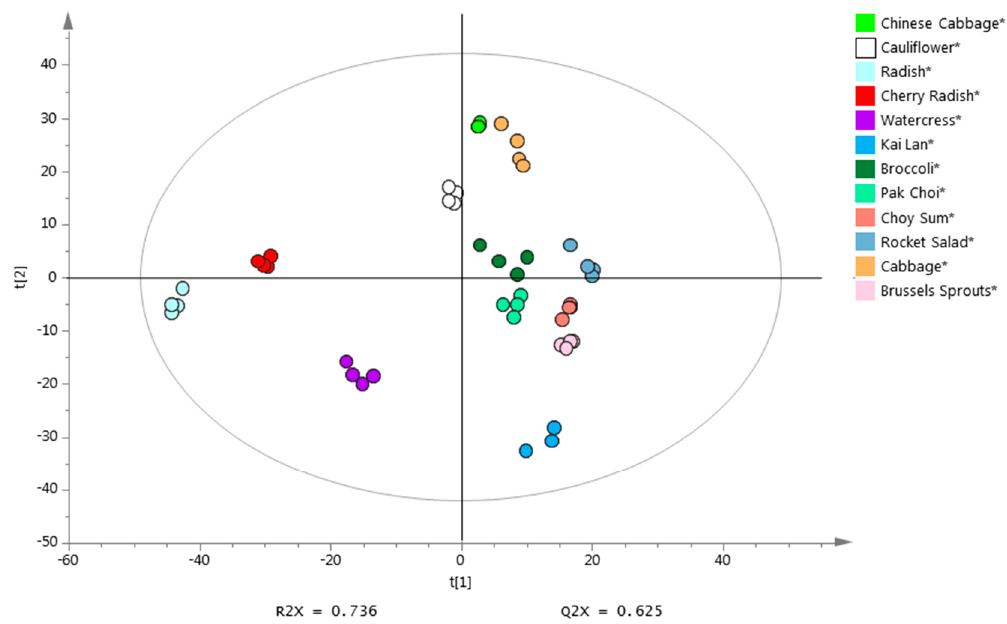
Figure 1. PCA analysis based on VOCs emitted from 12 Brassicaceae